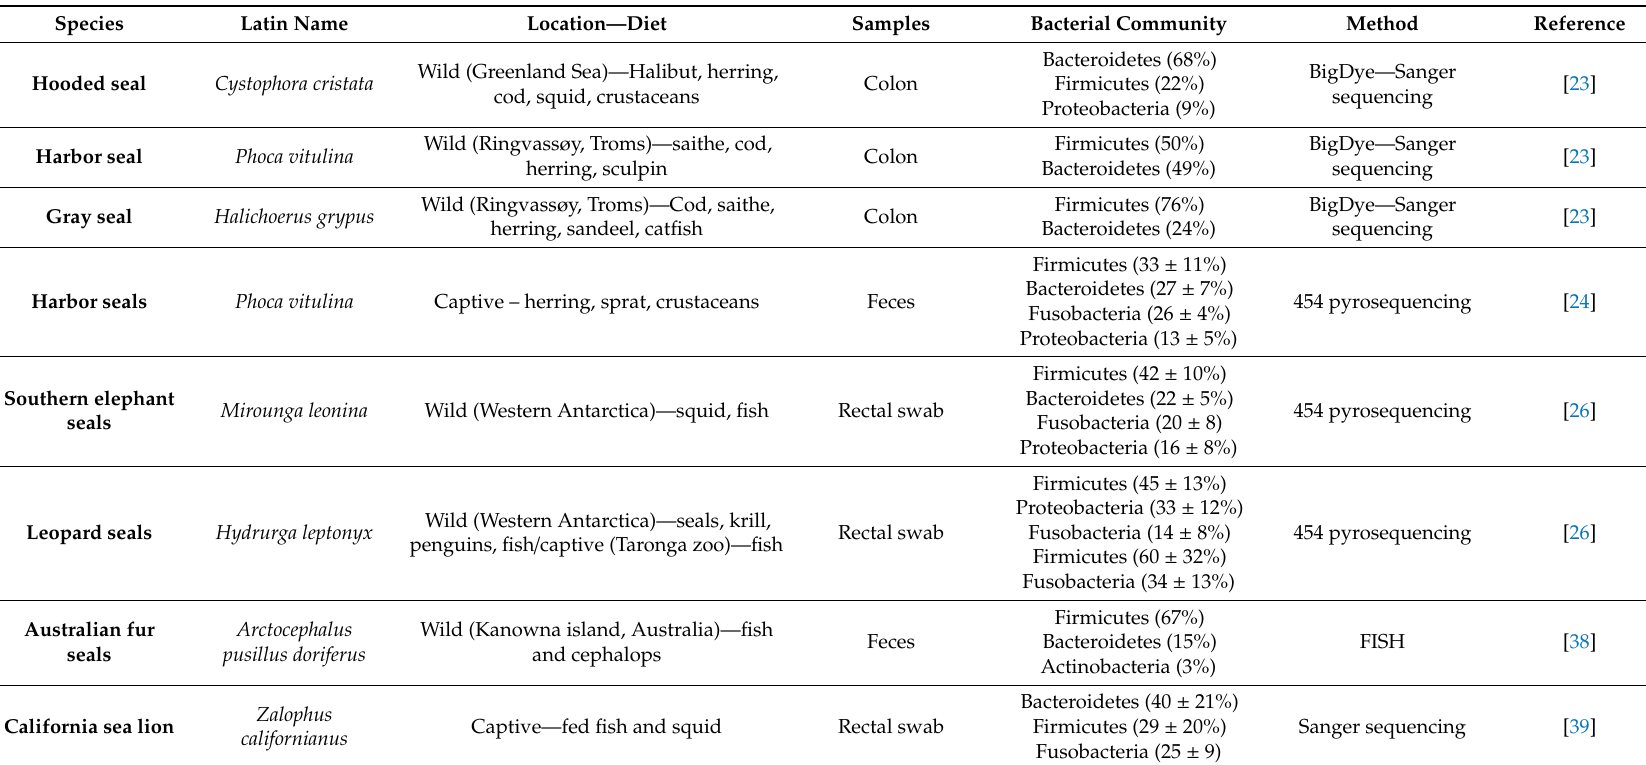
Table 1. Intestinal microbiota composition of carnivore marine mammals from Arctic and Antarctic latitudes. The results were presented per host animal species, living conditions (wild or captive), and sampling origin. Taxonomy was indicated at phylum level considering the total relative abundance. An indication on the applied methodology by which the results were obtained was also